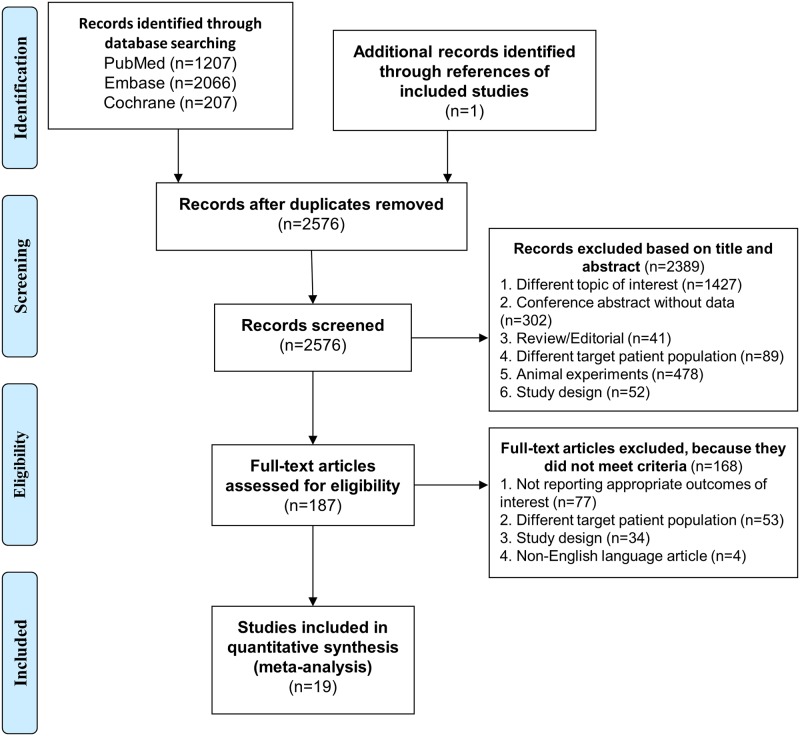
Flowchart of the study selection procedure.